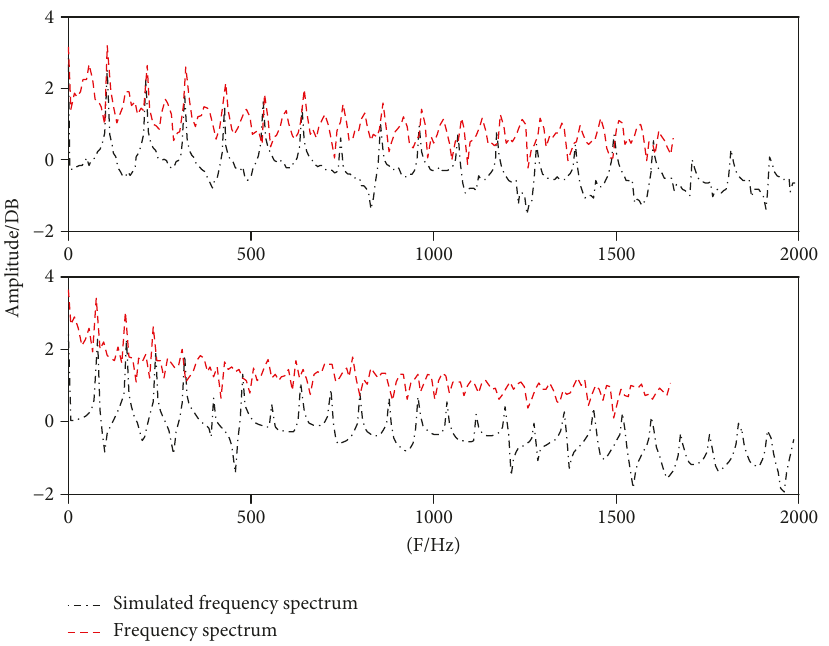
Figure 12: Matching results of samples 7 and 8 in the frequency